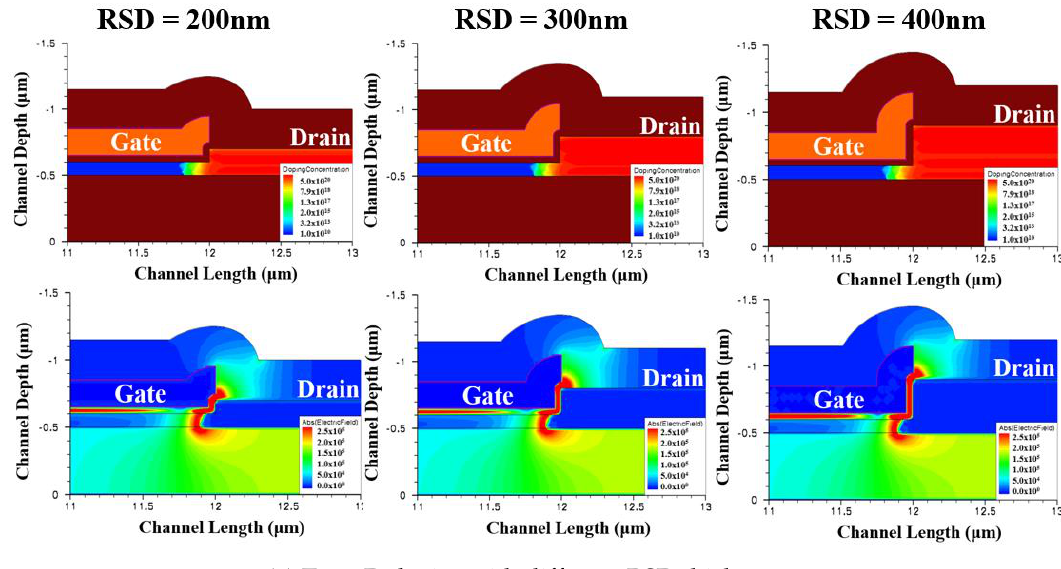
Figure 4. Drain side doping concentration profile (above) and drain electric field distributions (below) for a ( a ) traditional thin-film transistor (TFT) and ( b - e ) different types of RSD TFTs with RSD thicknesses of 200 nm, 300 nm, and 400 nm.